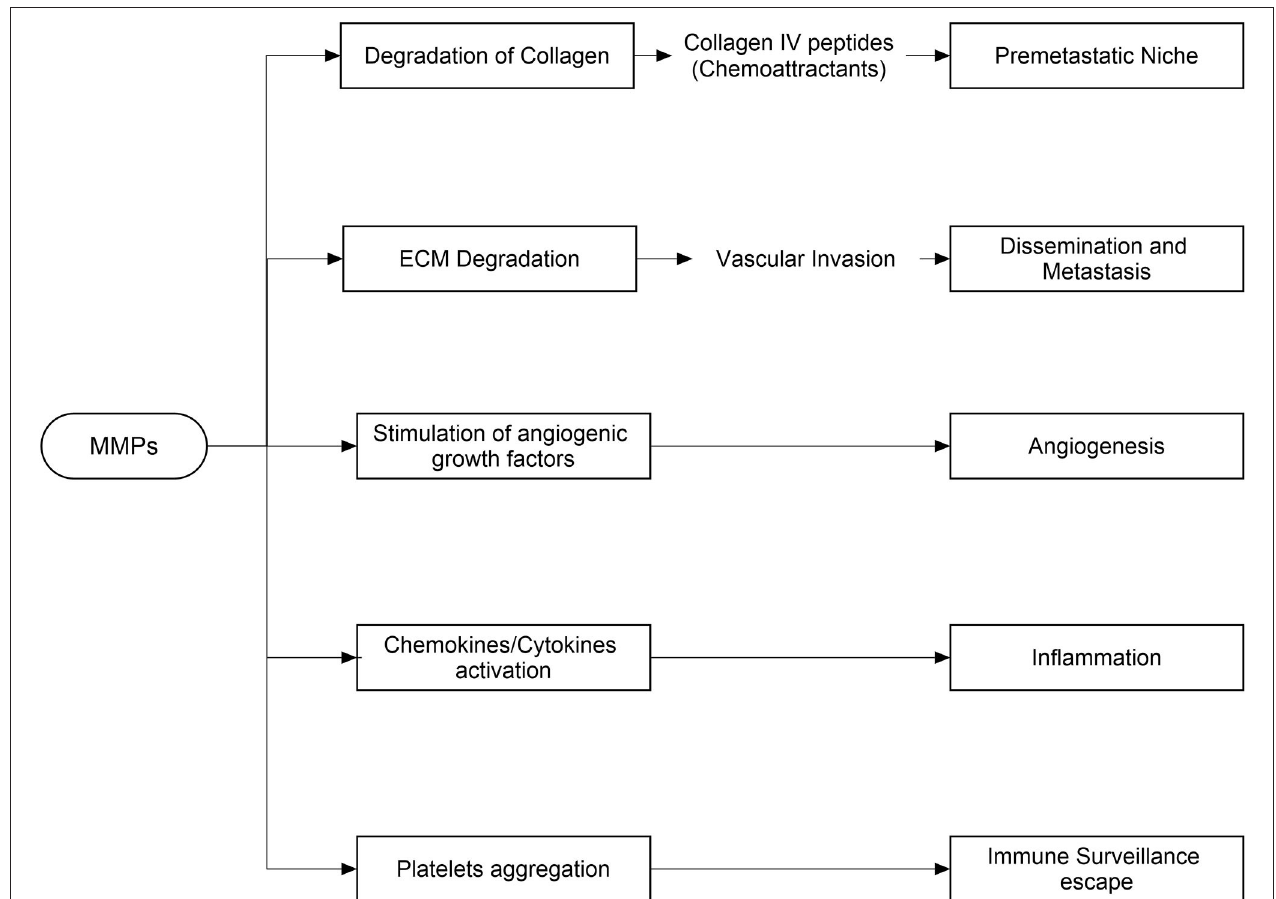
FIGURE 1 | Induction of cancer through matrix